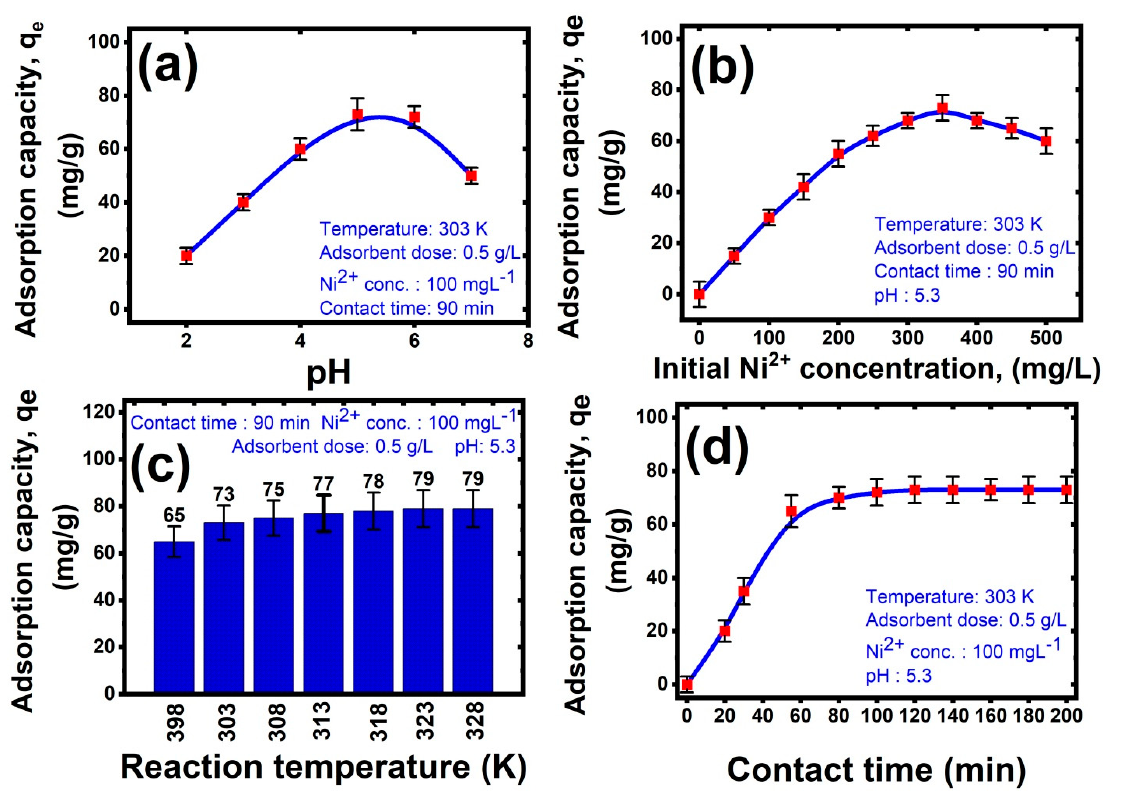
Figure 6. Effect of ( a ) pH, ( b ) beginning Ni 2+ concentration, ( c ) reaction temperature, and ( d ) contact time on Ni(II) removal by Al 2 O 3 /PVA nanocomposite.